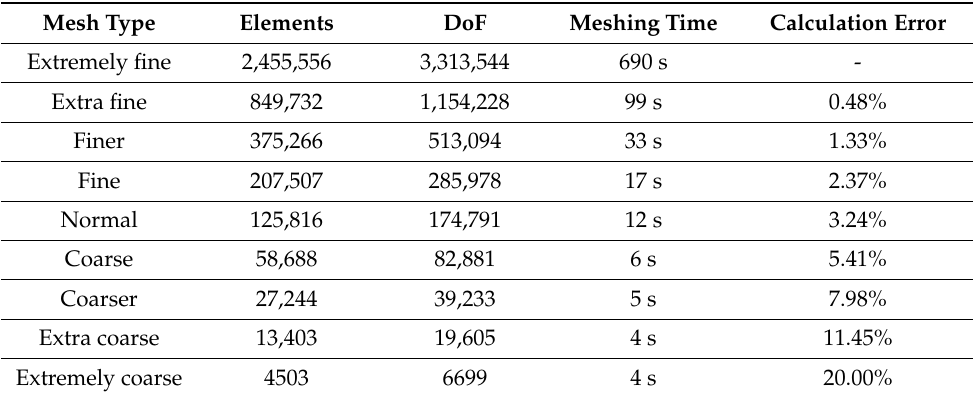
Table 2. Mesh statistics of automatic meshing.